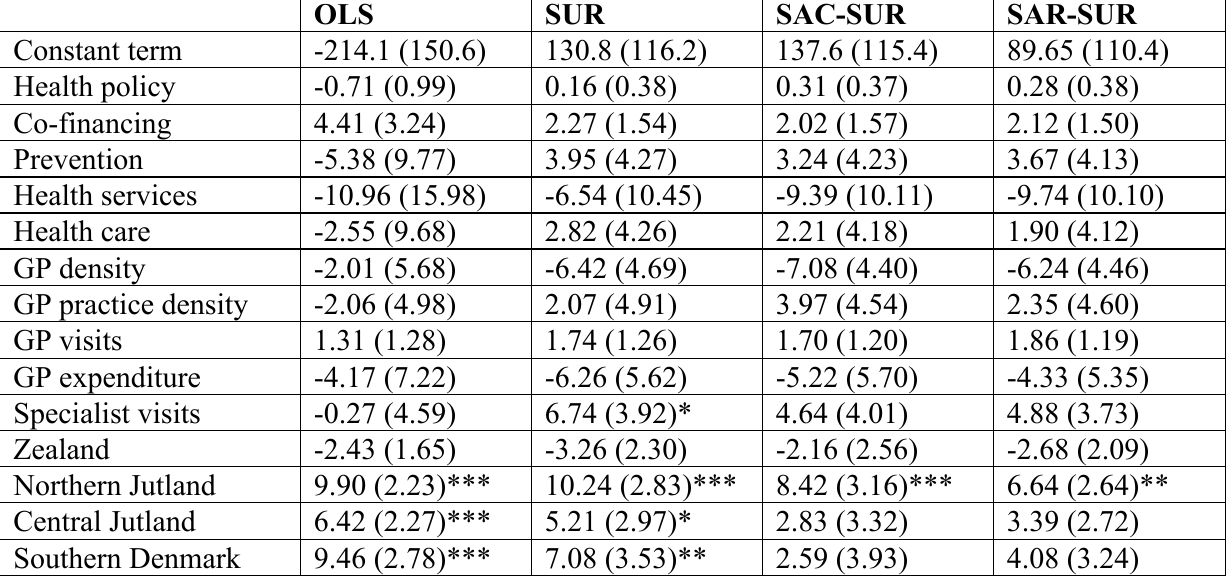
Table 4. Estimated specifications for asthma /